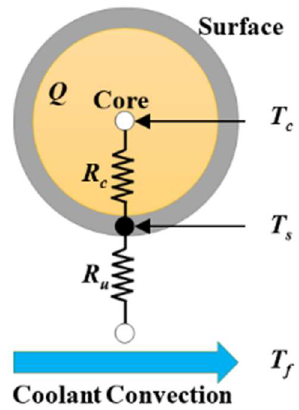
Figure 1. Schematic of thermal model of Li-ion battery cell.